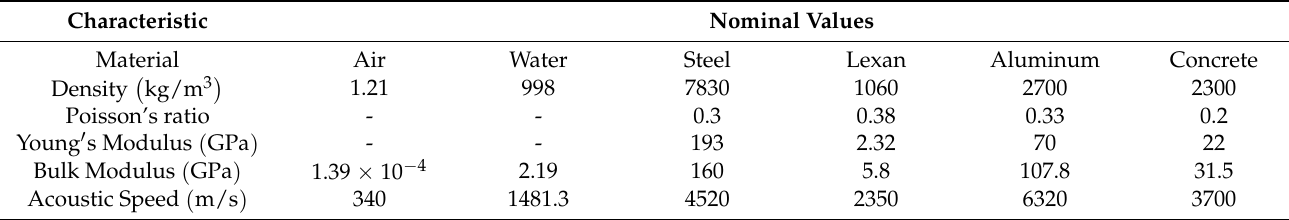
Figure 7. FEM of the full-scale bridge and its dominant modes in the fully inundated condition: ( a ) undeformed FEM; ( b ) 1st mode shape; ( c ) 4th mode shape; ( d ) 9th mode shape. Table 1. Physical properties of materials used for FEM-CAS